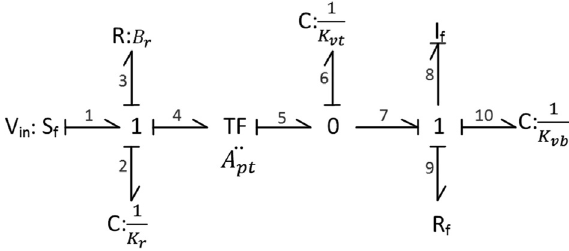
Fig. 2. Bond graph model of the semi-active